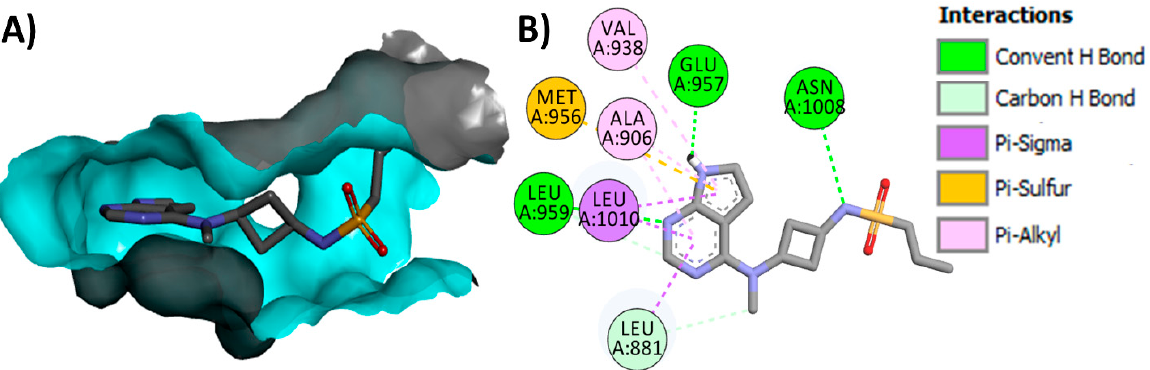
Figure 13. Binding modes of abrocitinib (shown as sticks) into JAK1 (pdb: 6BBU): ( A ) 3D binding mode, receptor shown as a hydrogen bond surface; ( B ) 2D binding mode showing different types of binding interactions with amino acids in JAK1; this figure was generated using Discovery Studio Visualizer (V16.1.0.15350).